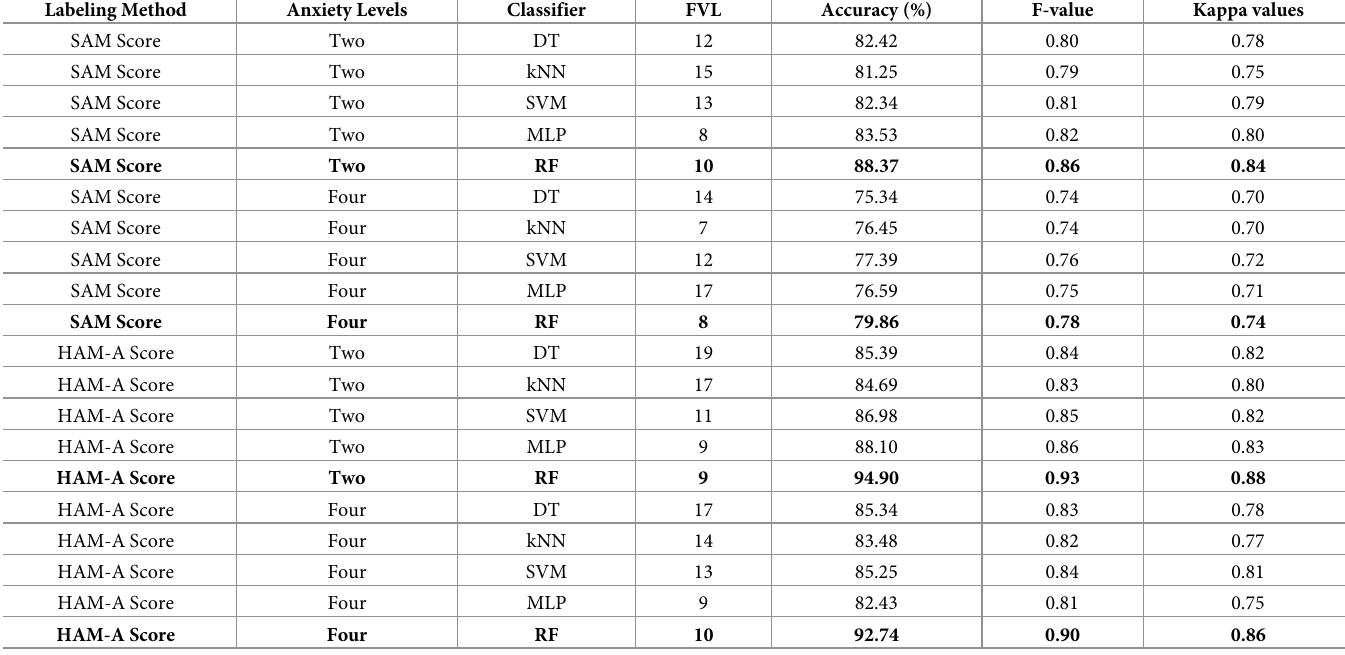
Table 1. Performance comparison of proposed anxiety classification framework using both SAM and HAM-A based labeling for two and four levels in terms of dif- ferent machine learning classifiers, Feature Vector Length (FVL), accuracy, F-value, and Kappa values